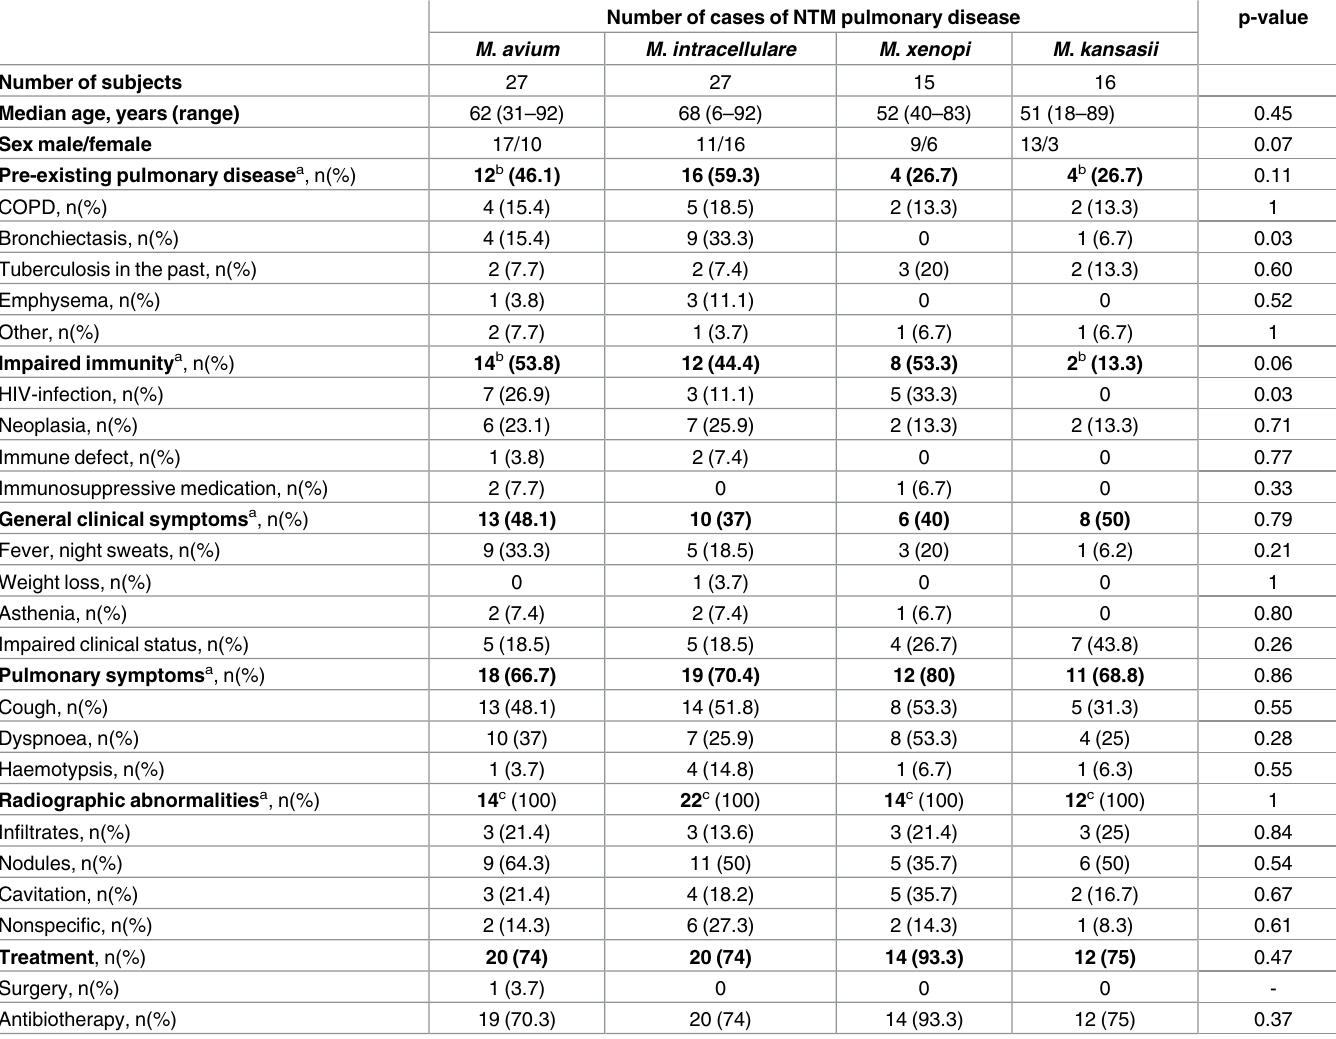
Table 3. Comparison of the characteristics of the patients with M . avium , M . intracellulare , M . xenopi or M . kansasii pulmonary disease included the study. Number of cases of NTM pulmonary disease